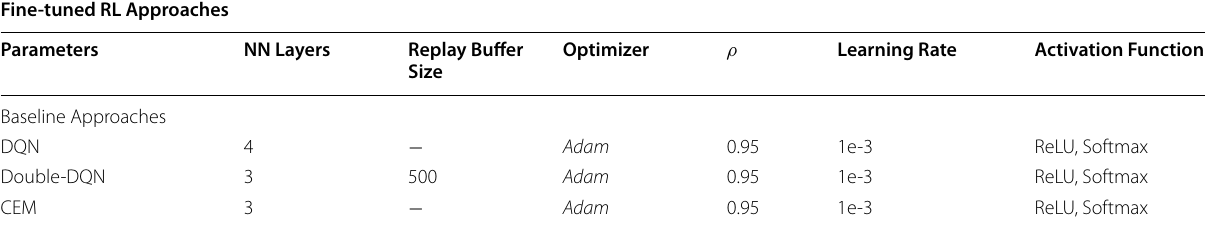
Table 4 Fine-tuned baseline approaches: we train DQN, Double-DQN, CEM based approaches as baselines of our proposed MLR-LC- DRLO